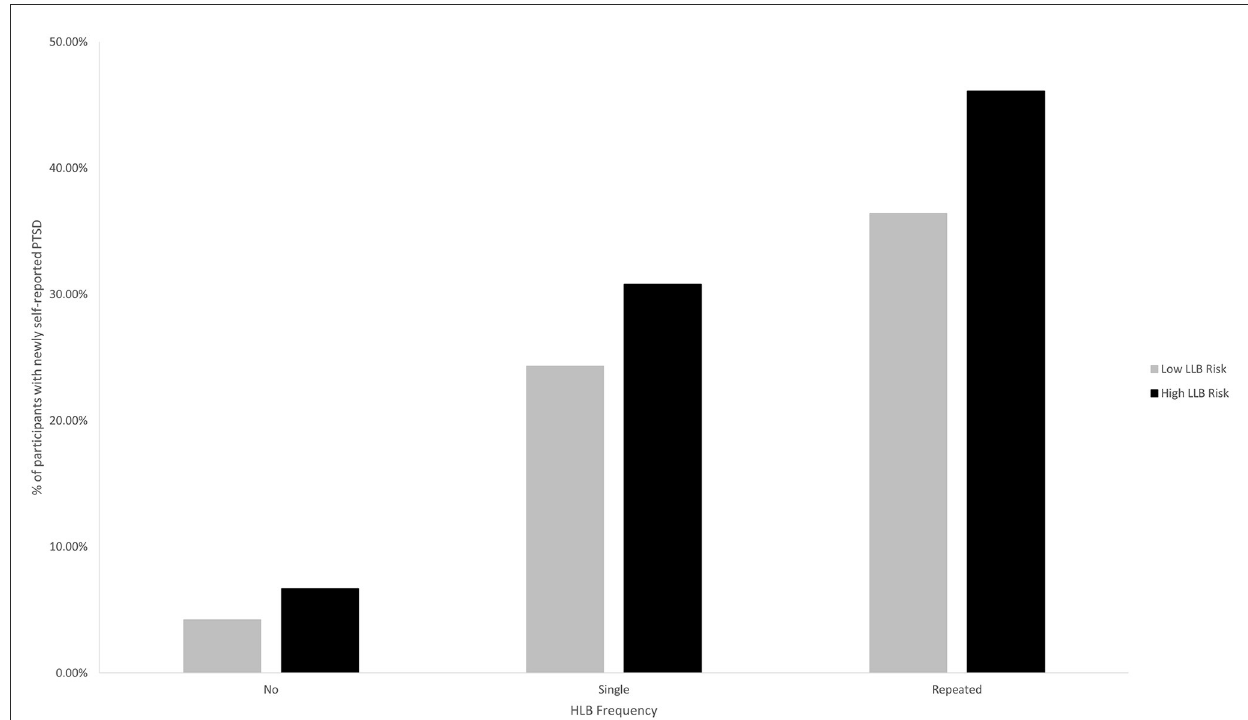
FIGURE2 Percentage of participants with newly self-reported PTSD as a function of occupational risk of LLB and HLB